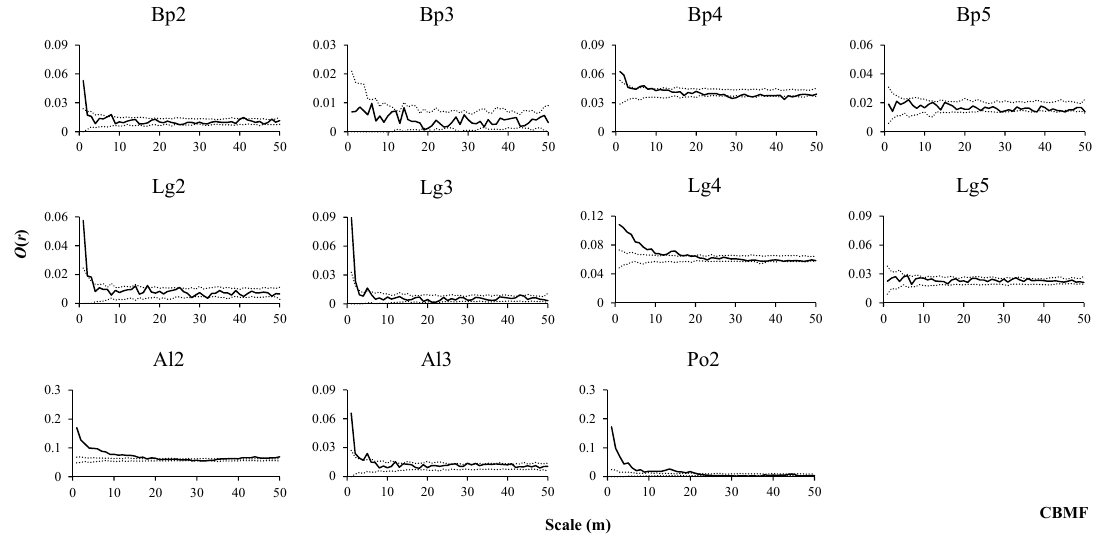
Figure 2. Spatial distributions of tree species in BF. O ( r ) values indicate the spatial aggregation degree of tree species, thin dashed lines indicate the upper and lower limits of the 95% simulation envelope of the univariate toroidal shift null model. Points above the upper envelope indicate an aggregated distribution, points between the envelopes indicate a random distribution, and points below the lower envelope indicate a uniform distribution (From Figure 2 to Figure 4). Bp1, Bp2, Bp3, Bp4, and Bp5 denote seedlings, saplings, small trees, medium-sized trees and adult trees of B. platyphylla , respectively. Other tree species at di ff erent growth stages were also expressed in this way (From Figure 3 to Figure 10).